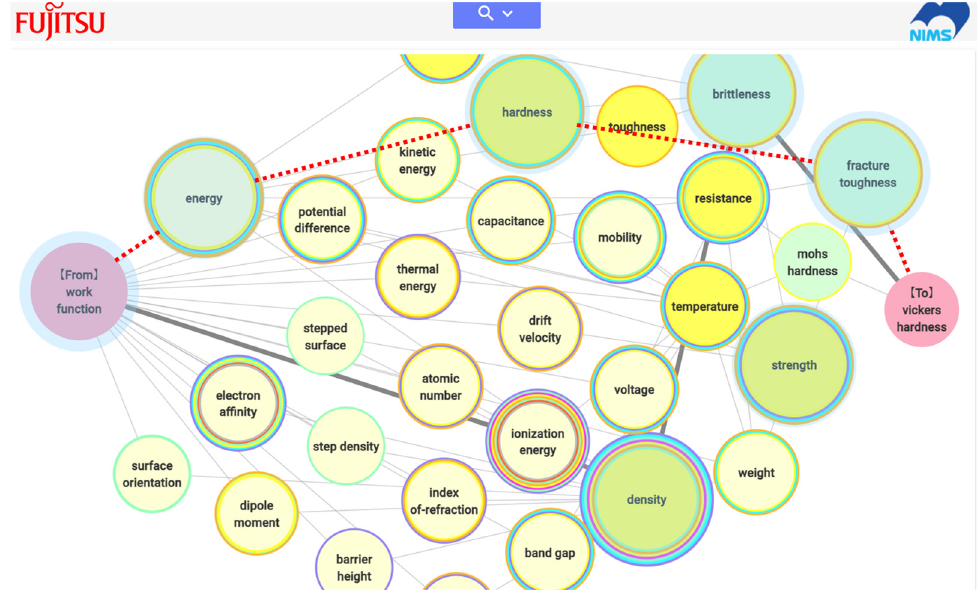
Figure 10. Computer system results screen showing a path search between the material properties of work function and Vickers hardness. Red dotted lines are shown for comparison with the manually compiled relationship in Figure 6.